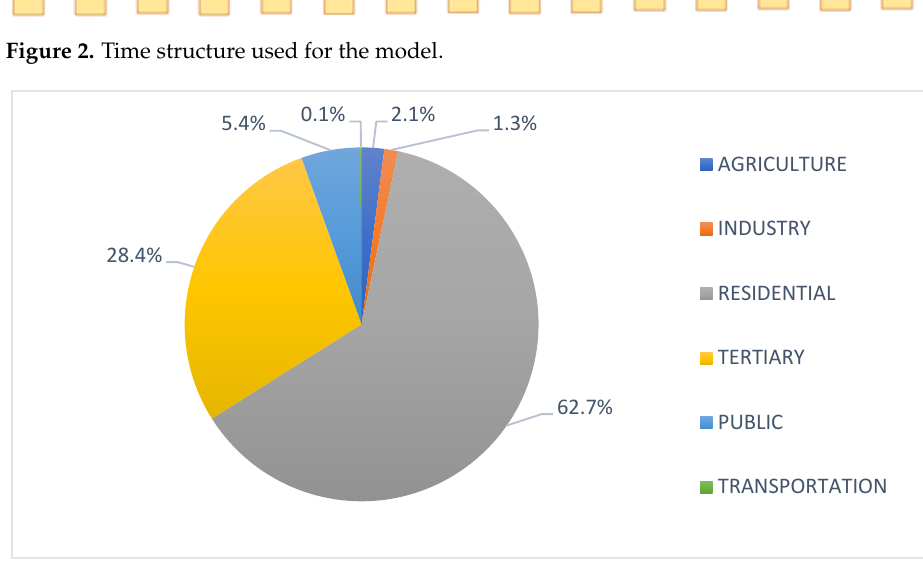
Figure 3. Procida ’ s electricity consumption share by sector in 2018. Figure 3. Procida’s electricity consumption share by sector in